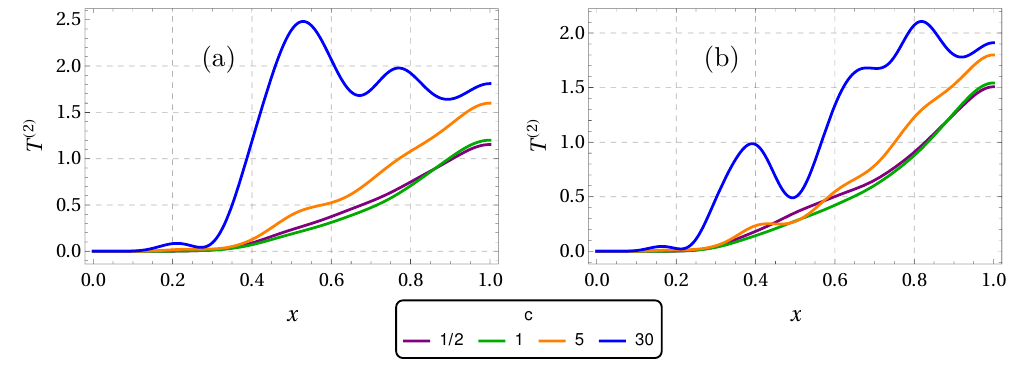
Figure 7 . The Trace Square Distance between the degenerate states at (a) h s = 4 , i.e. L − 4 | 0 i and L 2 | 0 i , and (b) h s = 5 , i.e. L − 5 | 0 i and L − 3 L − 2 | 0 i , for different values of the central charge c − 2